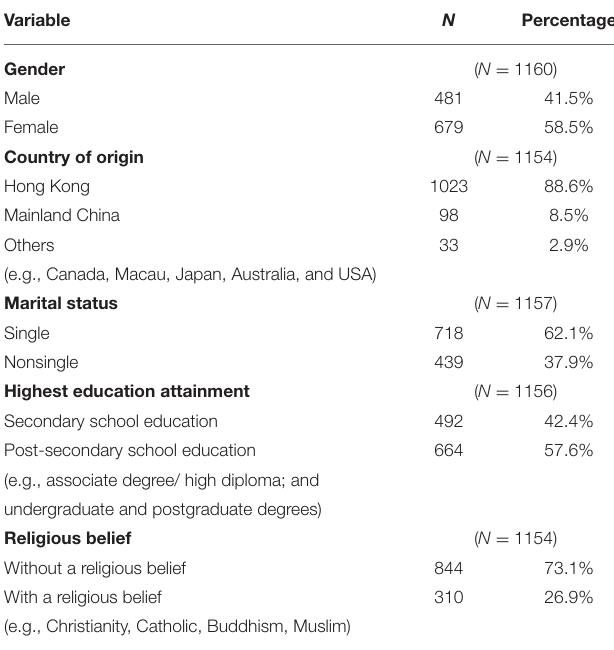
TABLE 1 | Sample demographic characteristics ( N =